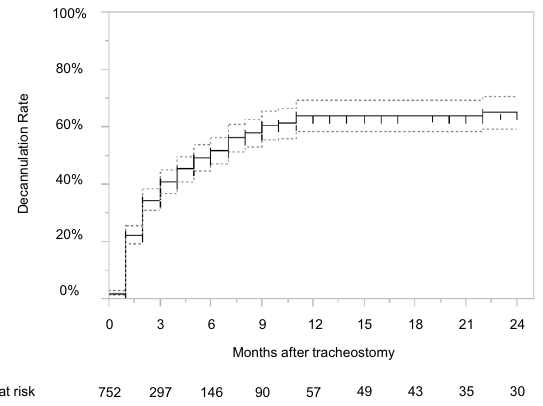
Figure 2. Kaplan–Meier curve for time to decannulation. Dotted lines represent 95% confidence intervals.